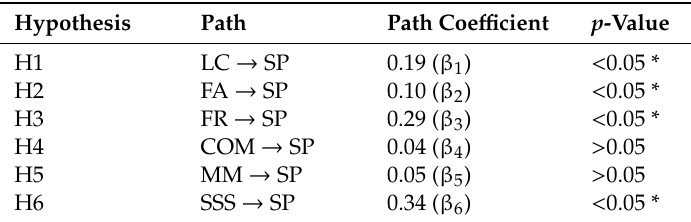
Table 3. Path results for the structural model.